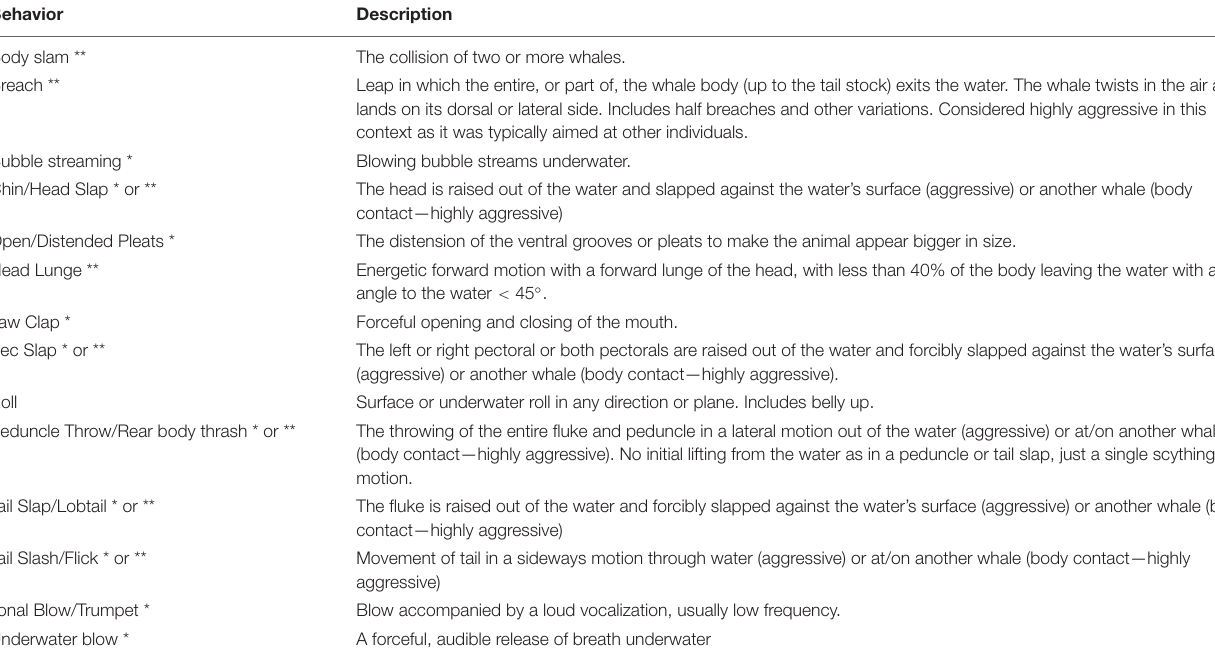
TABLE 1 | Behavioral ethogram for humpback whale competitive groups. Behavior Description